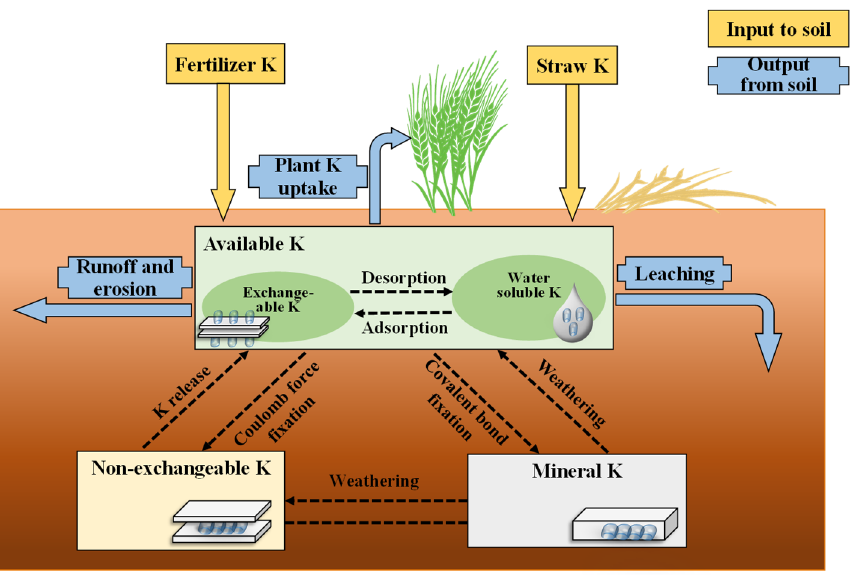
Figure 6. Relationship among available K, nonexchangeable K and mineral K in the soil-plant sys- tem.